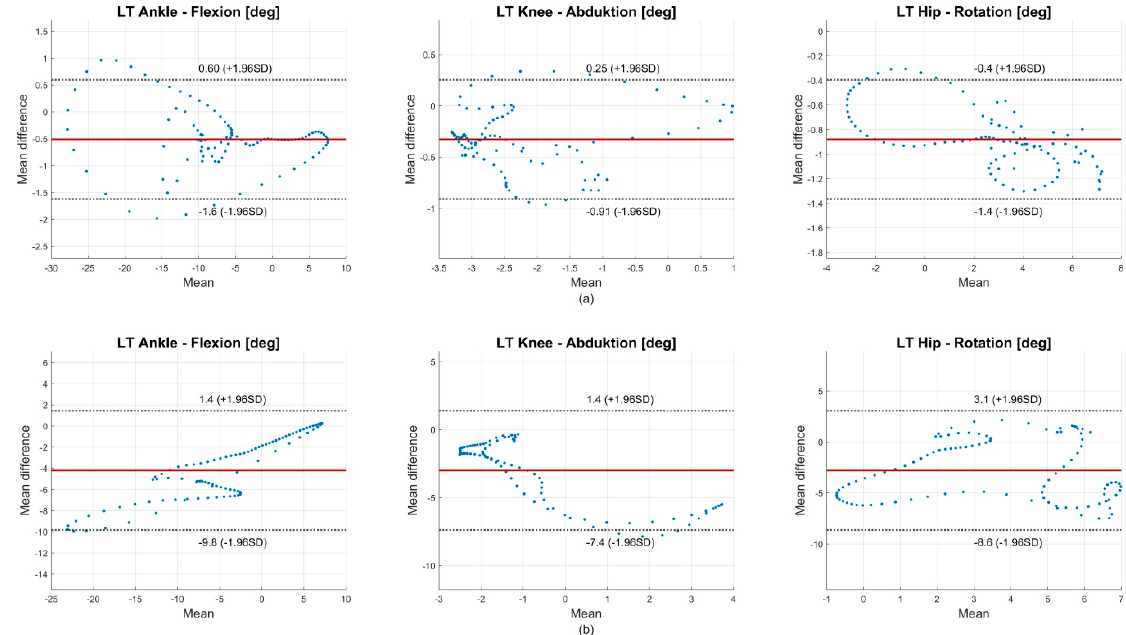
Figure 3. Bland-Altman (BA) diagrams for the most affected joint angles of every plane. The plots show the agreement between the 100% GC normalized joint angle waveforms of OMC and IMU system (averaged over all 28 participants). A normalized joint angle waveform contains 100 data points, which results in 100 data points in the BA diagrams. Upper row ( a ) shows condition 1, the lower row ( b ) condition 2. The solid line indicates the mean difference. The dashed lines indicate the limits of agreement (LoA) (95% CI of the mean difference).